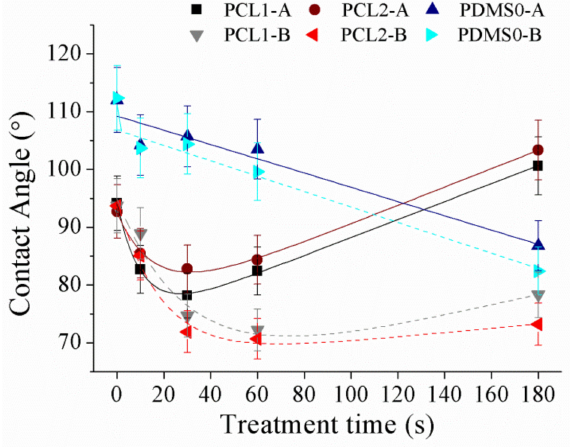
Figure 6. The water contact angle of PCL and PDMS films after treatment with SF 6 at various parameter